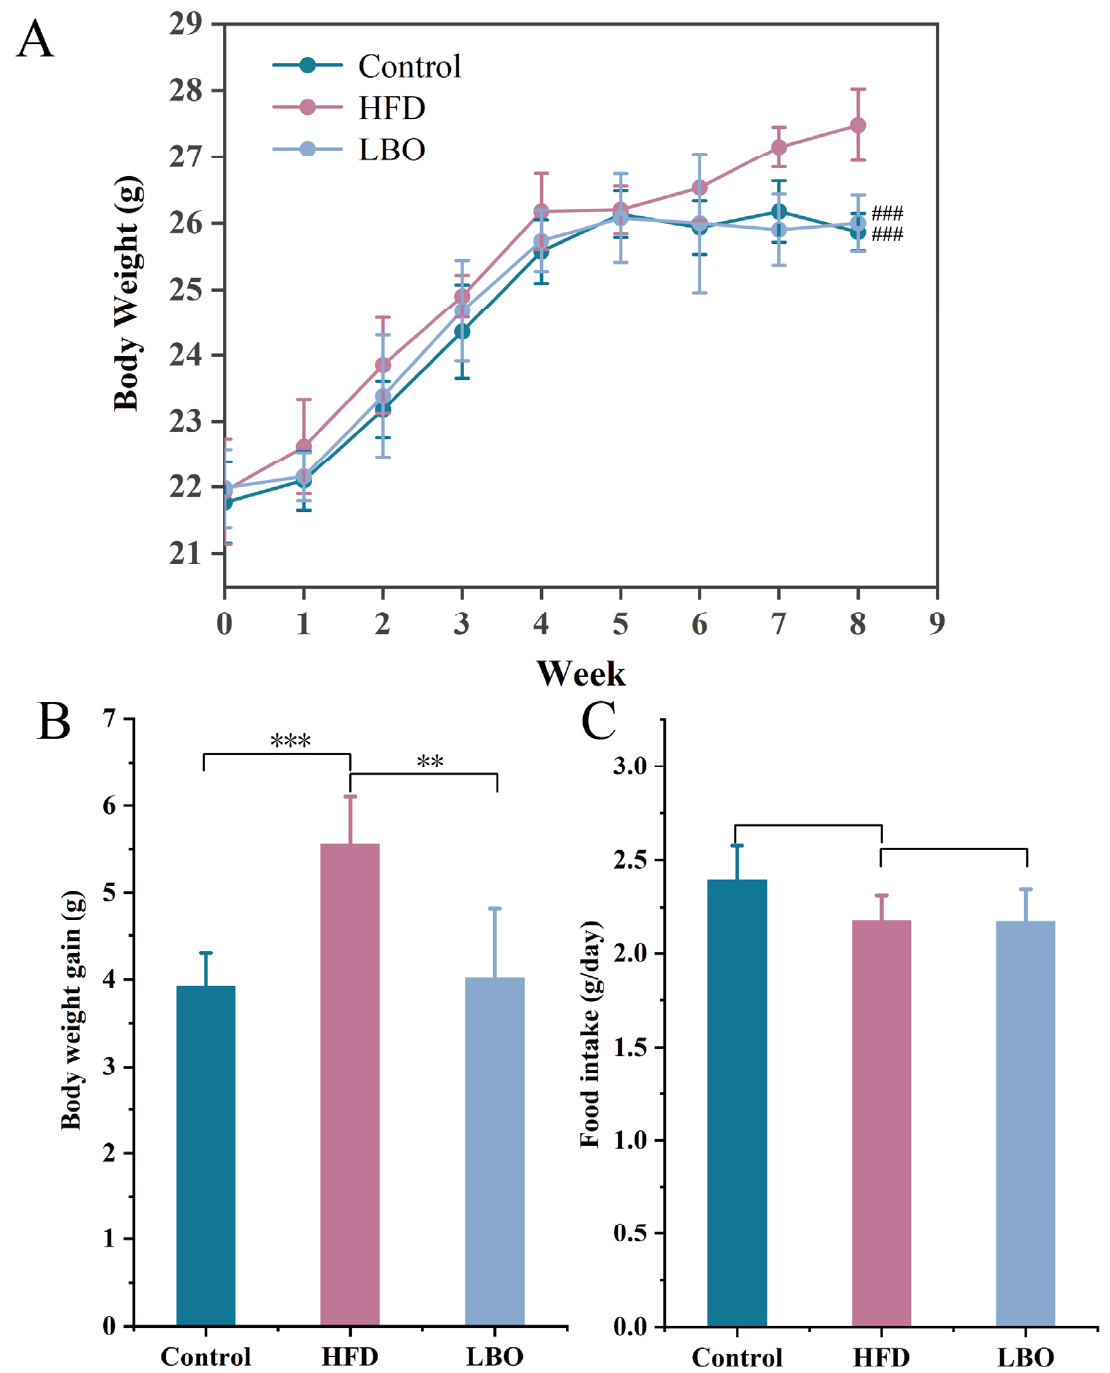
Figure 2. Ability of LBO to affect body weight changes in HFD-fed mice. ( A ) Change in the body weight of mice after eight weeks of housing. ### p < 0.001 vs. the HFD group. ( B ) Amount of body weight gain in mice. ( C ) Daily food intake of mice. Figures are presented as the mean ± SD, n = 6. ** p < 0.01, *** p < 0.001. LBO: Lycium barbarum oligosaccharide; HFD: high-fat